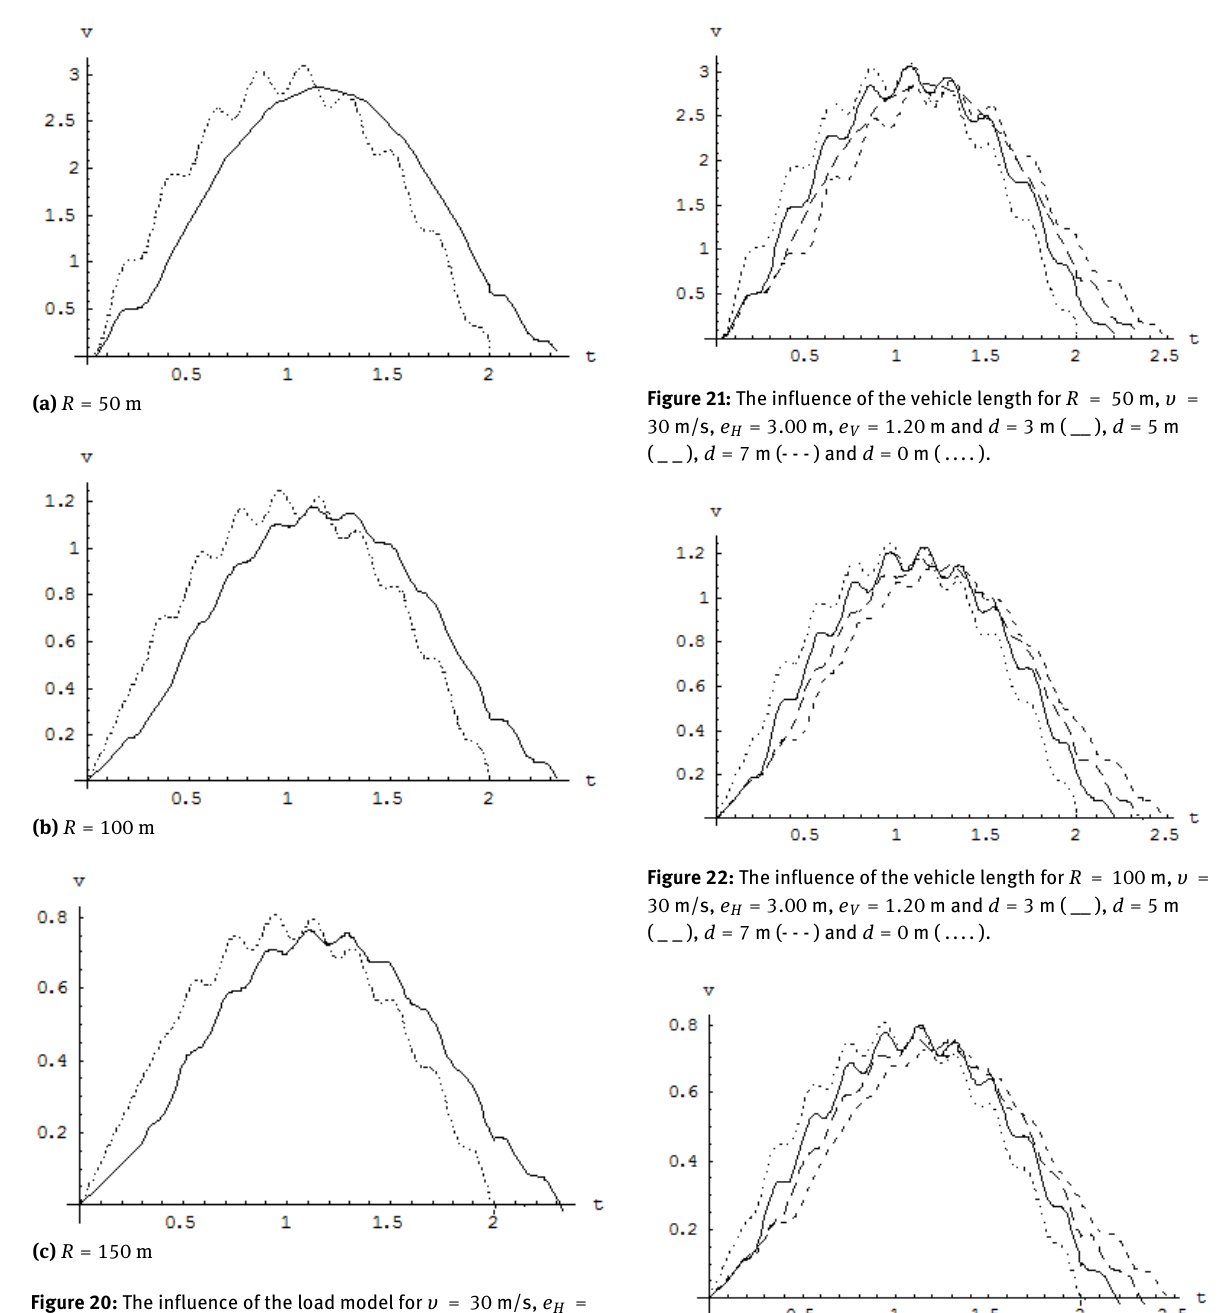
Figure 20: The influence of the load model for υ = 30 m/s, e H = 3.00 m, e V = 1.20 m, for a vehicle with 2 d = 10 m ( ___ ), one concentrated load ( - - - ).